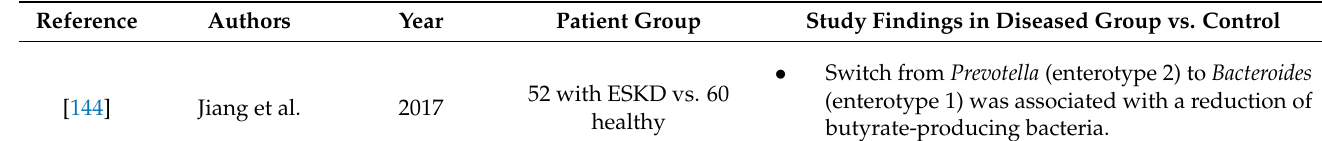
Table 8. Studies of the gut microbiota in chronic kidney disease (CKD) in